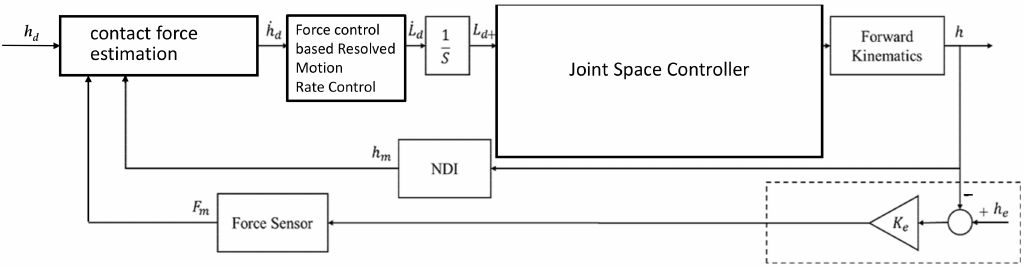
Figure 4. Block diagram for